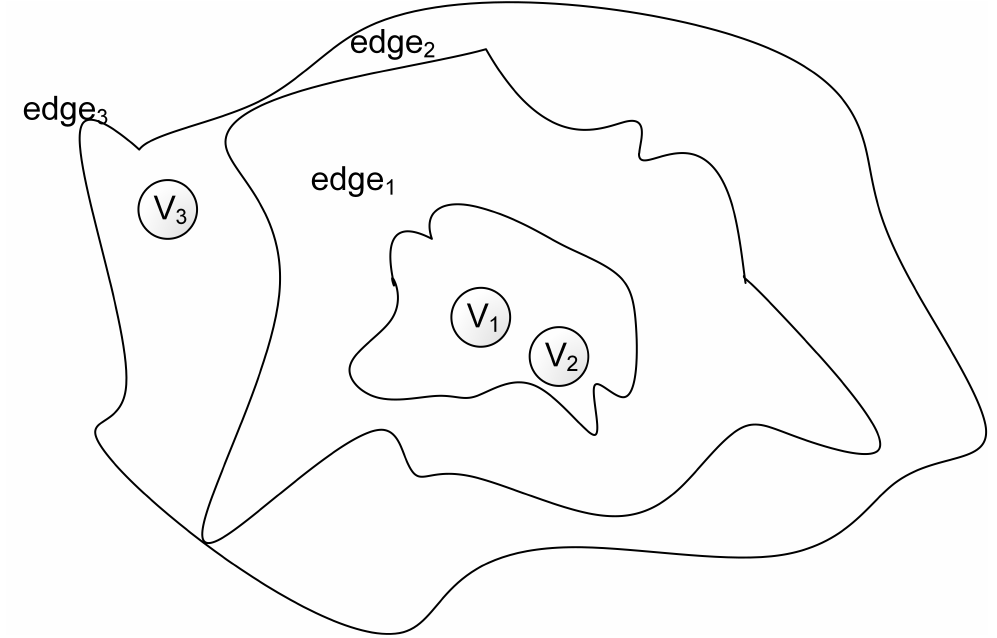
Figure 4. Representation of a Generalized